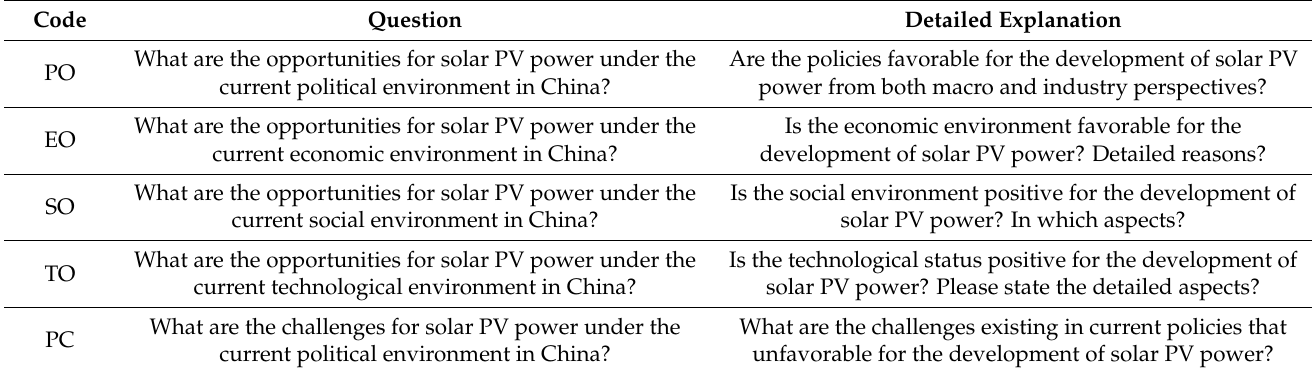
Table 1. Profiles of the consultations.